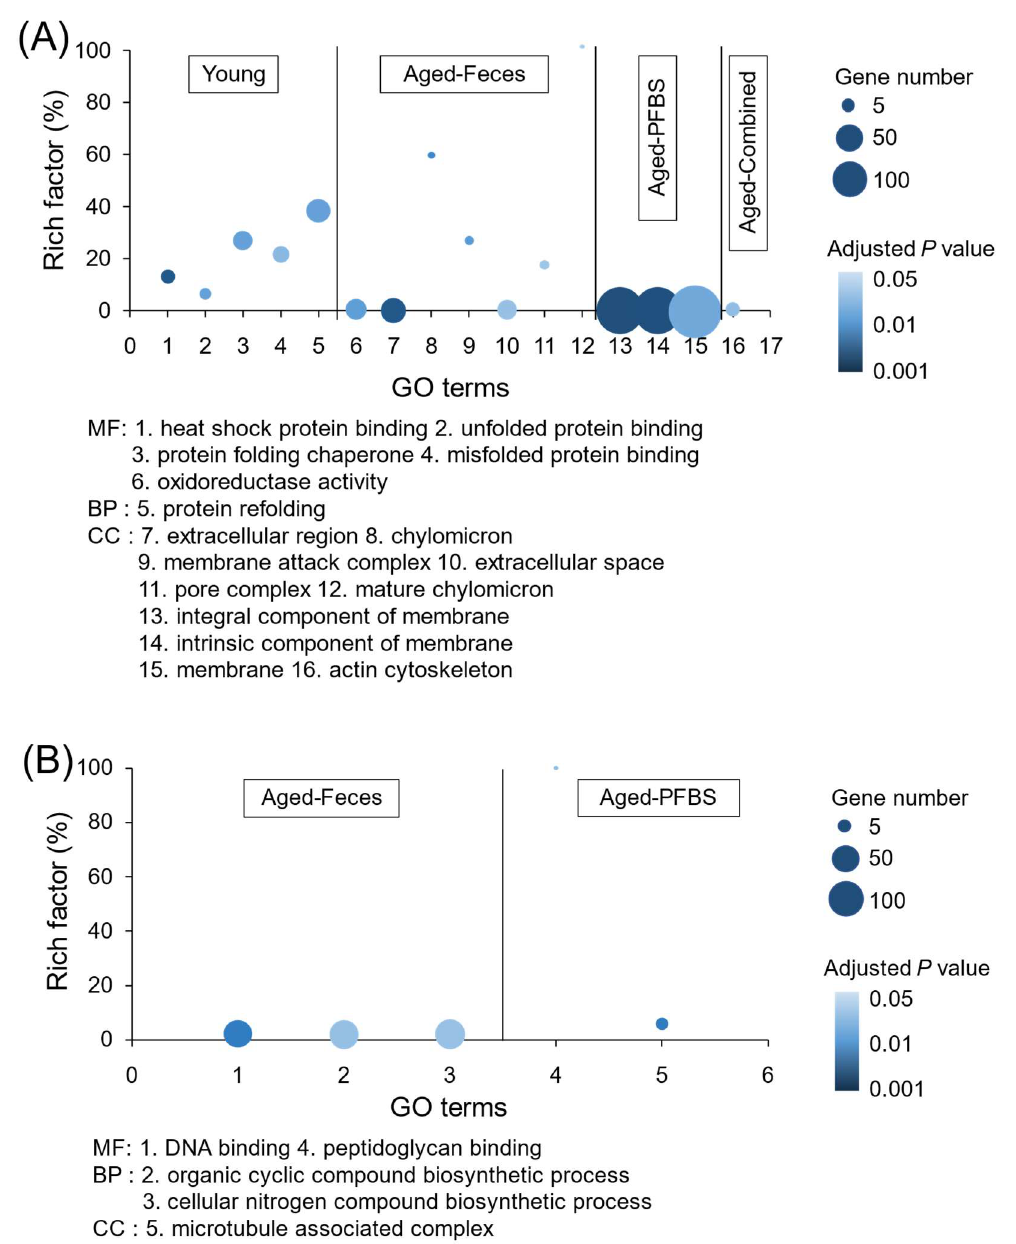
Figure 5. Significantly enriched GO terms (MF, molecular function; BP, biological process; CC, cellular component) in male ( A ) and female ( B ) zebrafish gonads after exposure to PFBS (0 and 100 µg/L) with or without the transplantation of young donor feces. Color intensity is proportional to the enrichment significance (adjusted p value). The circular area represents the number of inclusive genes.